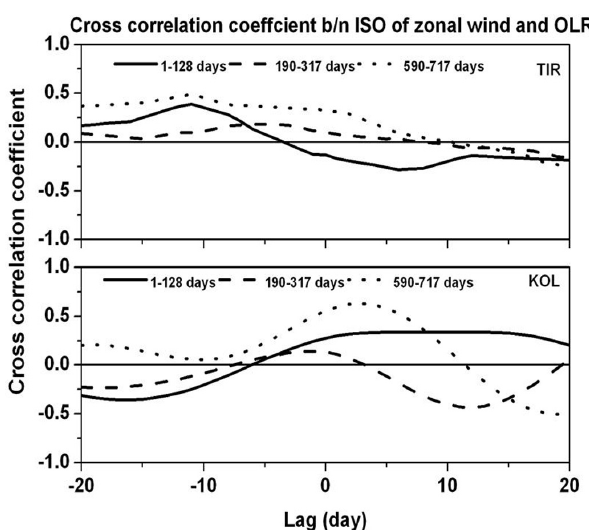
Fig. 11. Cross-correlation functions (CCF) between the ISO in zonal winds and the ISO in OLR, for three different time periods: (a) 1–128 days, (b) 190–317 days, (c) 590–717